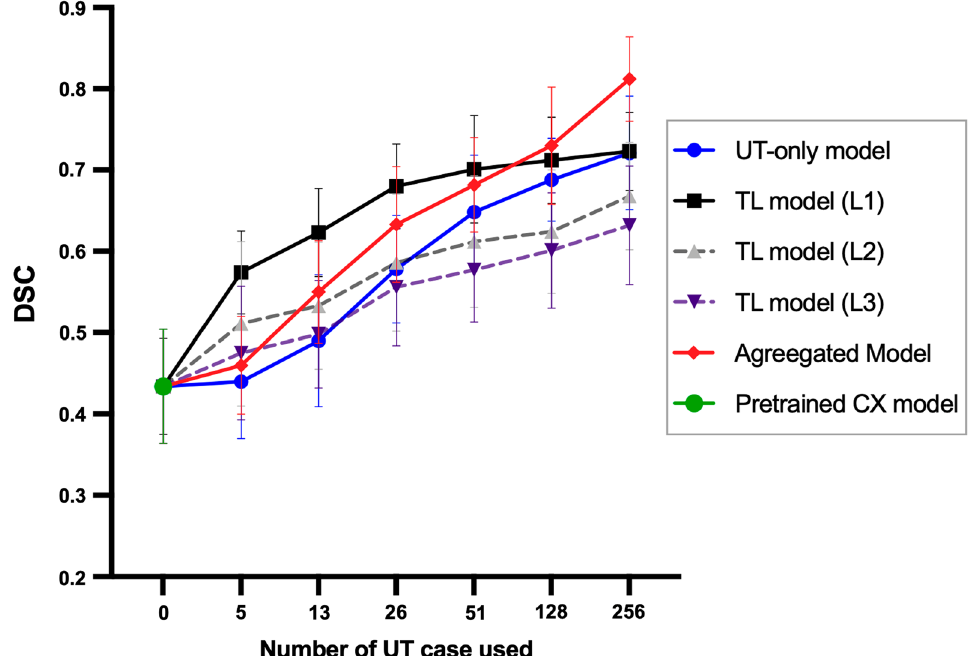
Fig. 3 Performances of models in predicting the combined cervical and uterine dataset using various training combinations and sample sizes on the uterine tumors (UT) dataset. The L1, L2 and L3 in TL models indicate the fine‑tune levels as indicated in Fig. 1. Data are expressed as means with error bars of standard